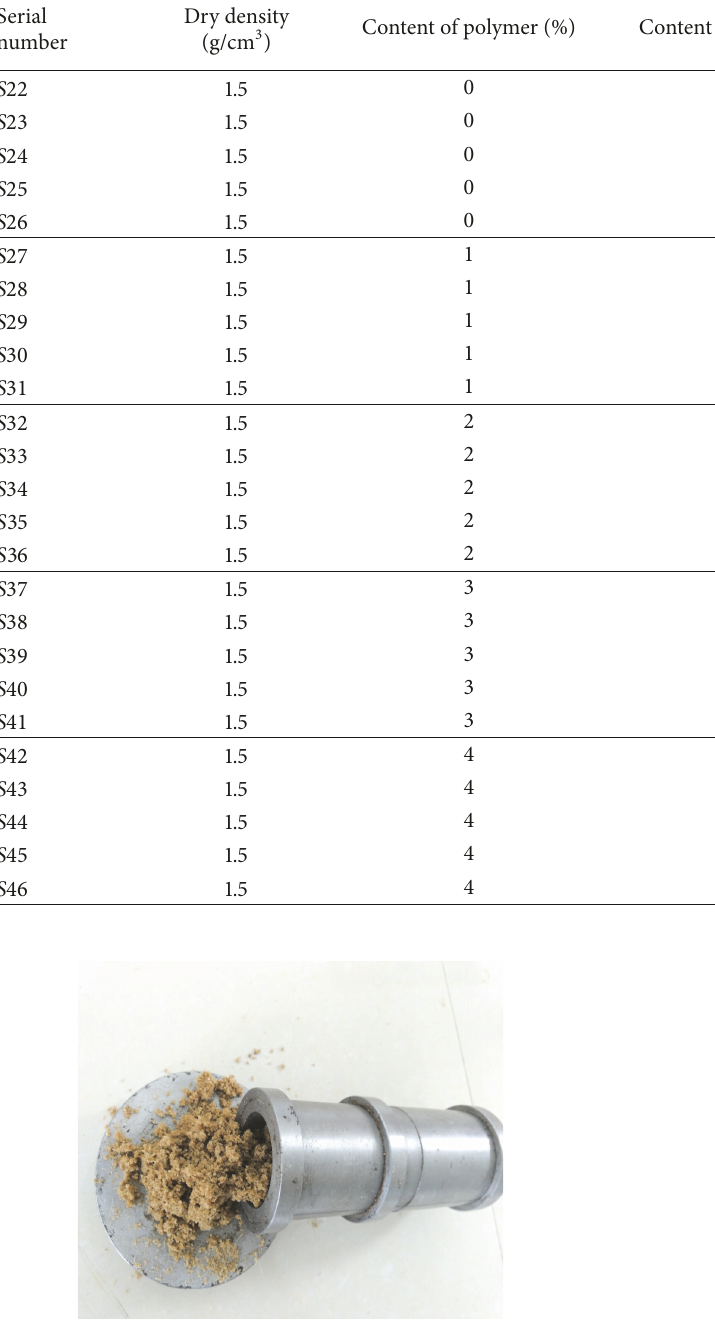
22.99, 41.88, 52.69, and 106.14 kPa, respectively. It can be seen from Table 3 that the unconfined compression strength of samples is improved by the reinforced material of polymer- fiber. The strength improving is affected by the content of polymer and